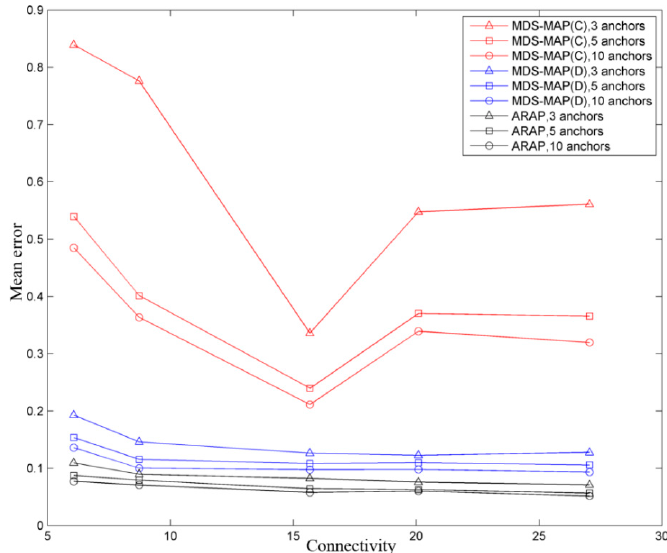
Figure 8. Mean error as a function of the anchor nodes and connectivity in a grid WSN topology.